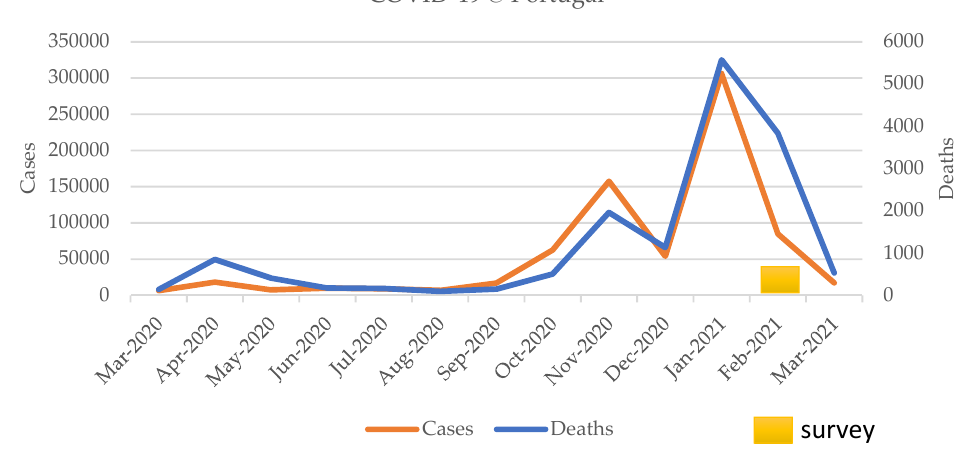
Figure 1. COVID-19 cases and deaths in Portugal during the survey timeframe.